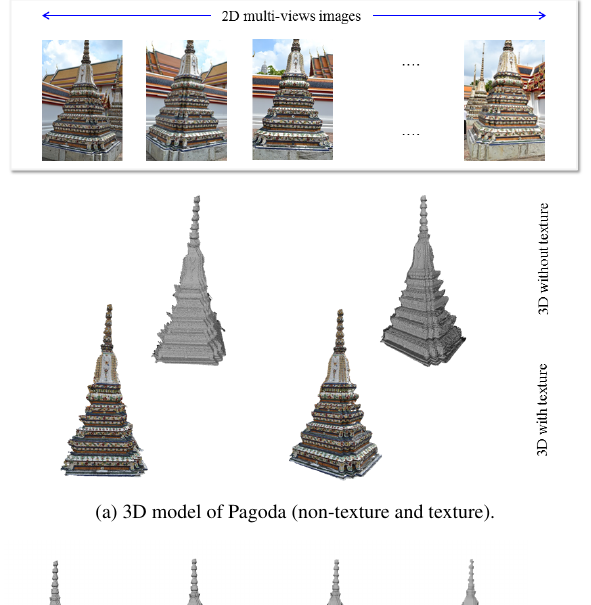
(a) 3D model of Pagoda (non-texture and texture).